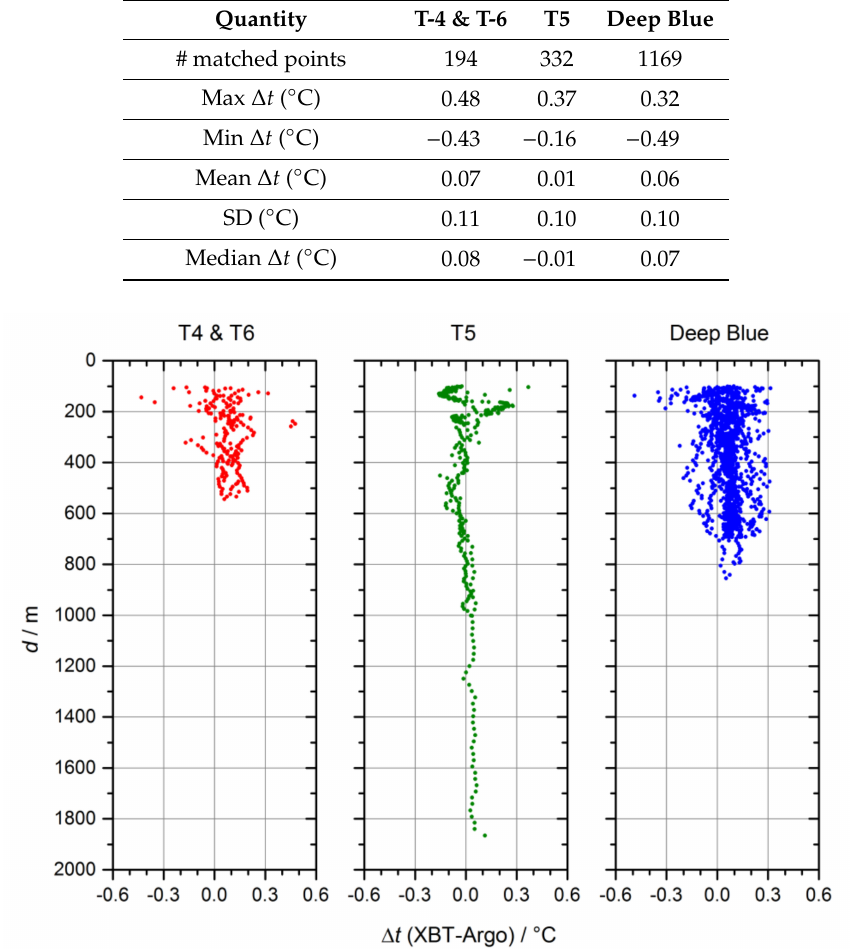
Figure 10. Temperature di ff erences vs. depth ( d > 100 m) for all the (XBT-Argo) pairs separated less than 10 km in space and within a 1-day time